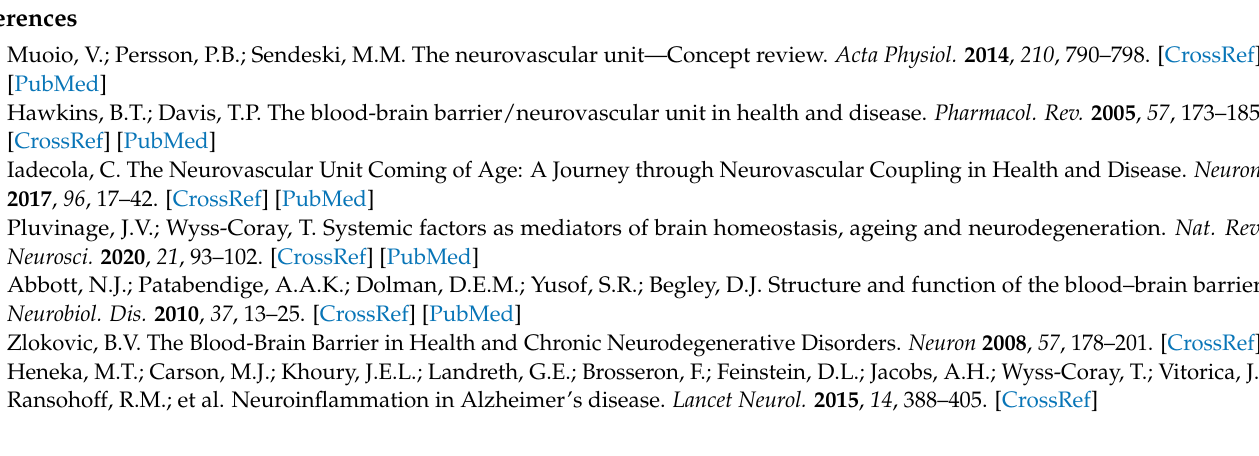
Table S1: Induction medium composition. Table S2: Specification medium composition. Table S3: Fac- tory medium composition. Table S4: Microglia medium composition. Table S5: Co-culture medium composition. Table S6: Co-culture cytokine data. Table S7: BMEC monoculture cytokine